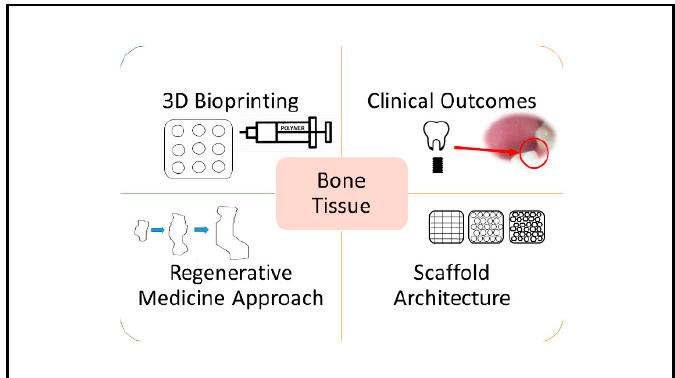
Figure 1. Current trend of research focuses concerning bone tissue engineering.